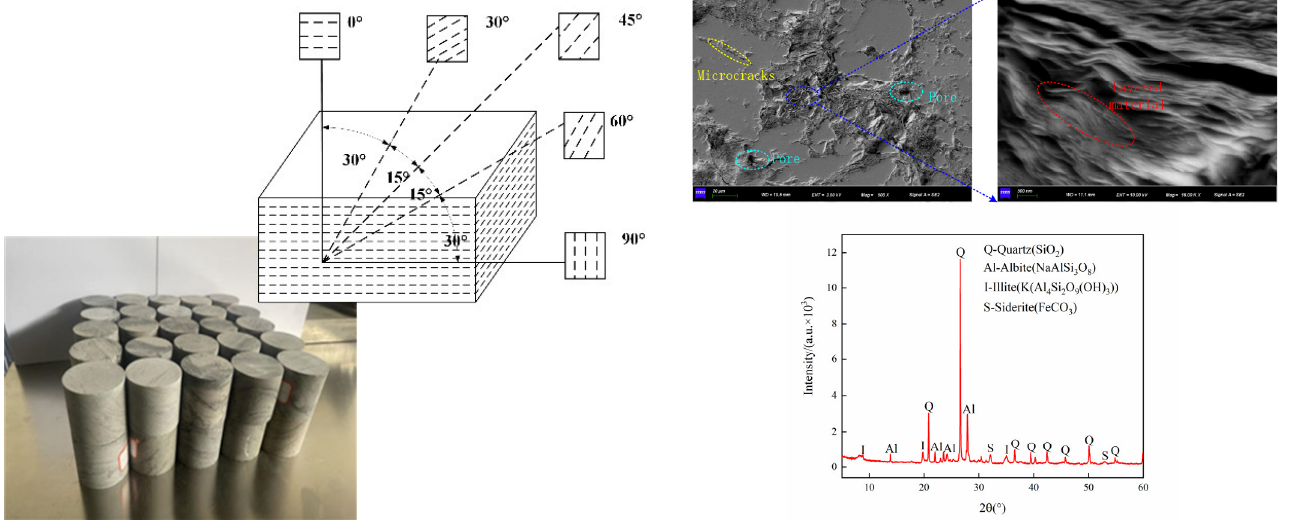
Figure 1. Typical samples and XRD and SEM scanning images.